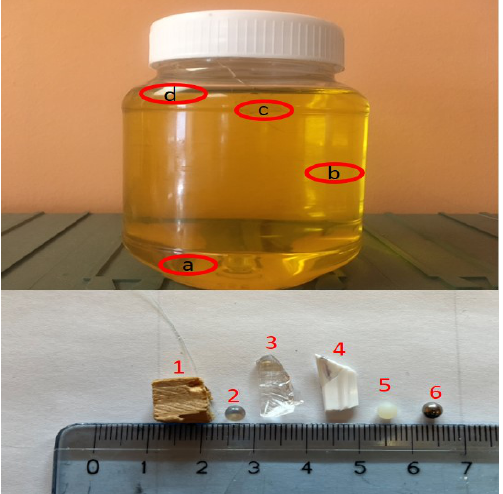
Figure 2. Uncontaminated jar sample filled up with oil. The image includes different types of contaminants, numbered from 1 to 6, and the circles drawn on the jar (a,b,c, and d) refer to the most probable positions of the contaminants materials inside the